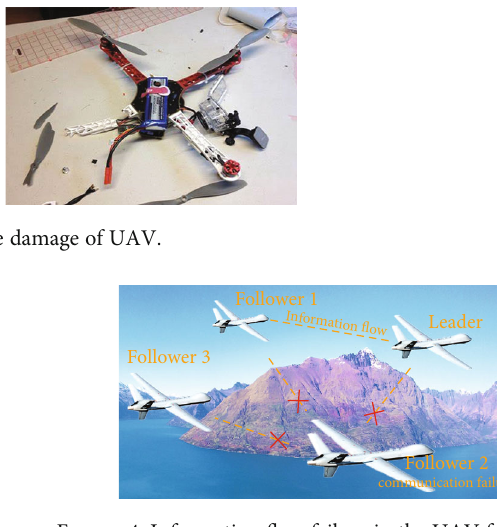
Figure 4: Information fl ow failure in the UAV